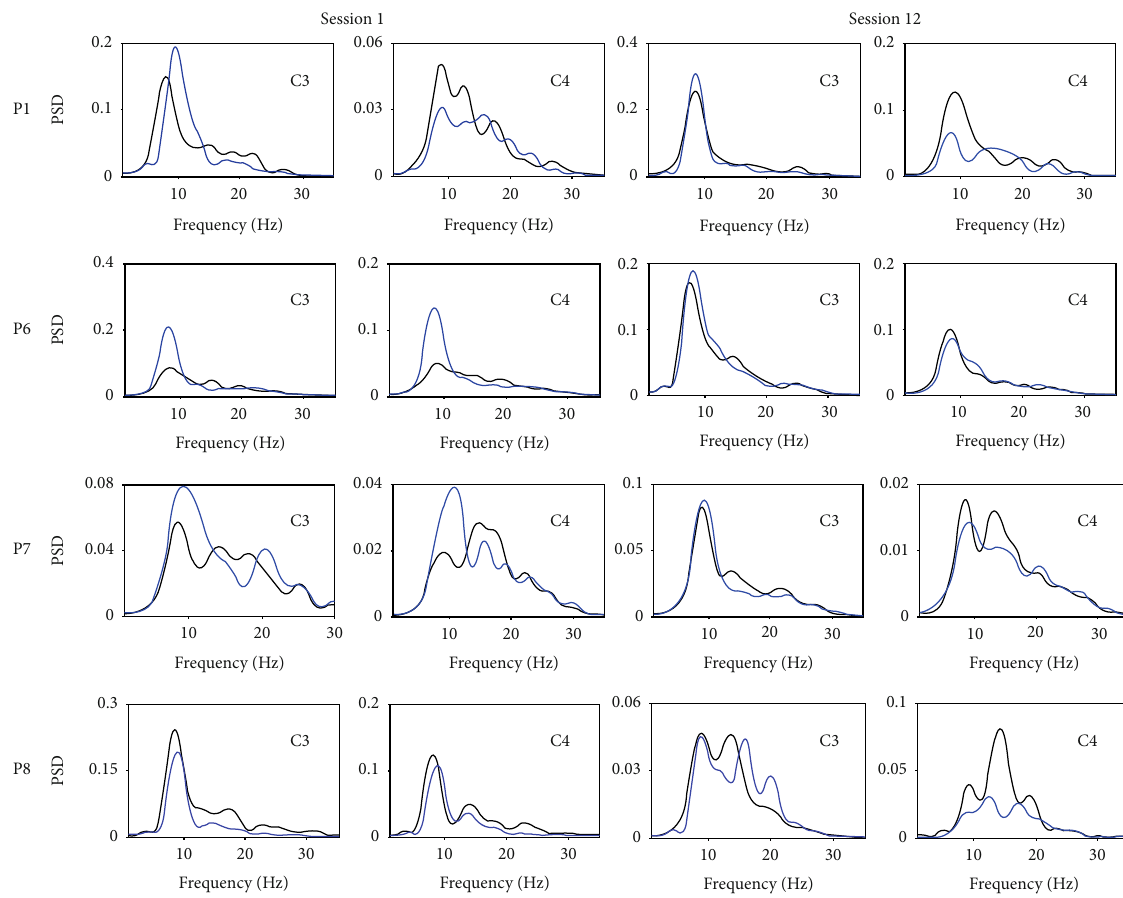
Figure 4: The power spectral density maps from electrodes C3 and C4 for four participants in the BCI group (blue: right motor imagery, black: left motor imagery).